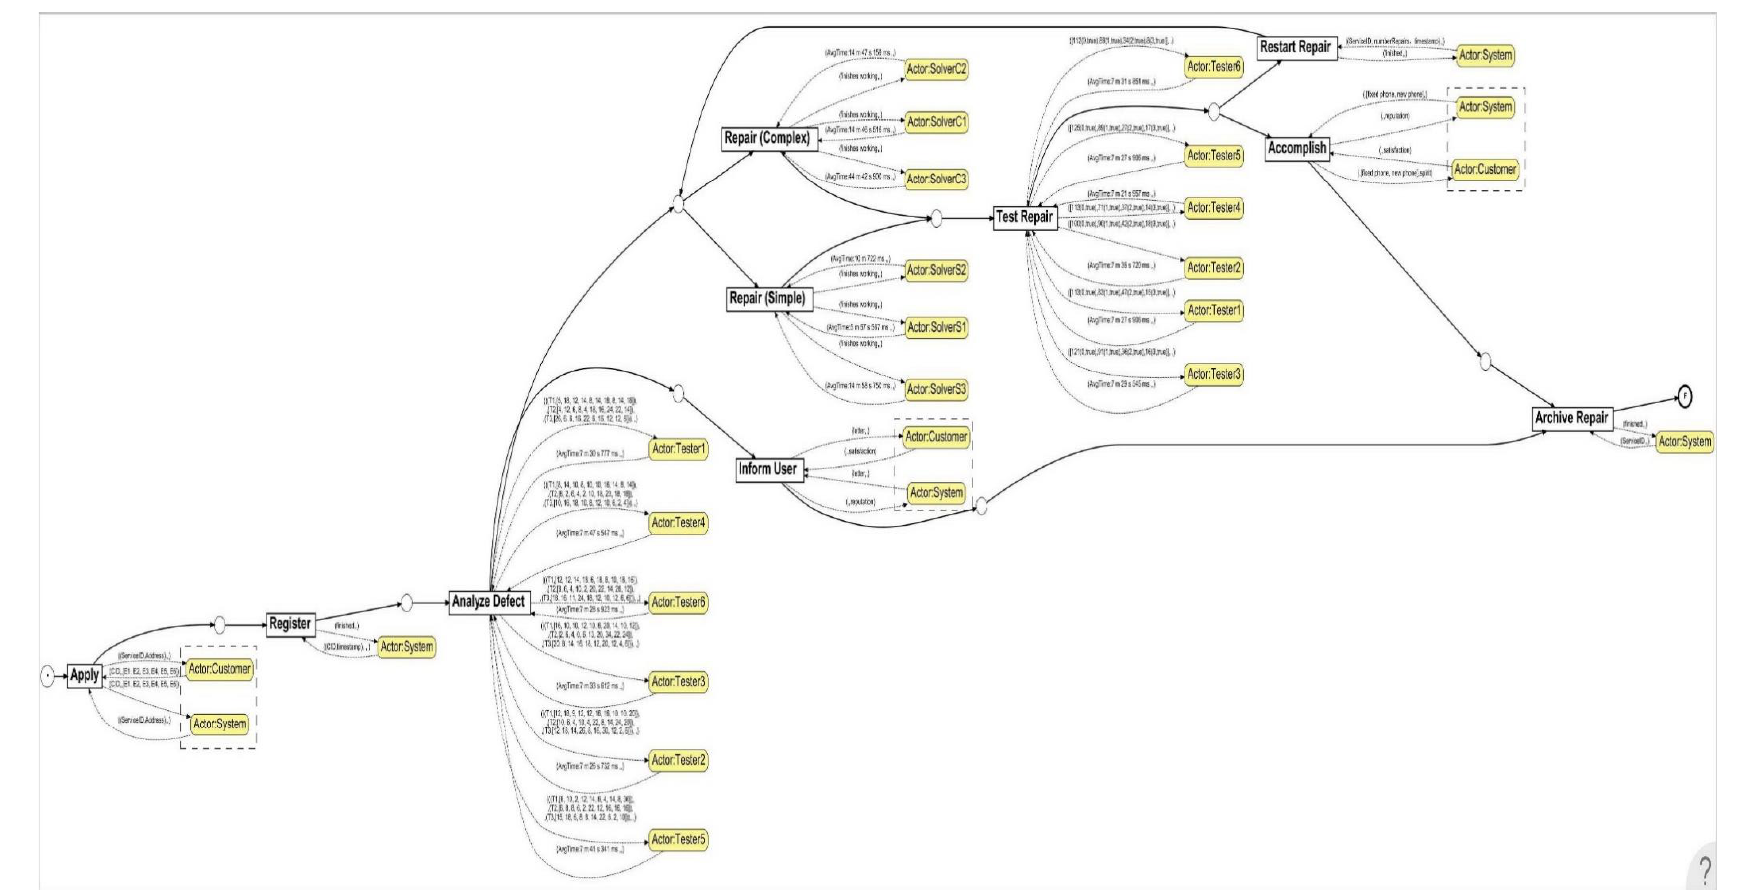
Figure 11. Service process value model of the running example.